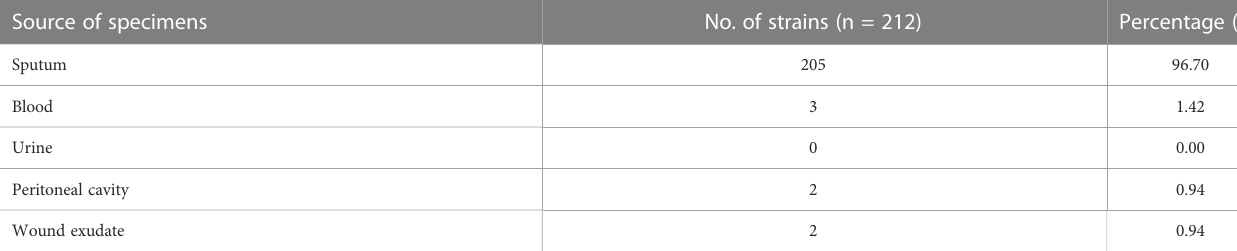
TABLE 2 Sources of specimens in which pathogenic CR-GNB were